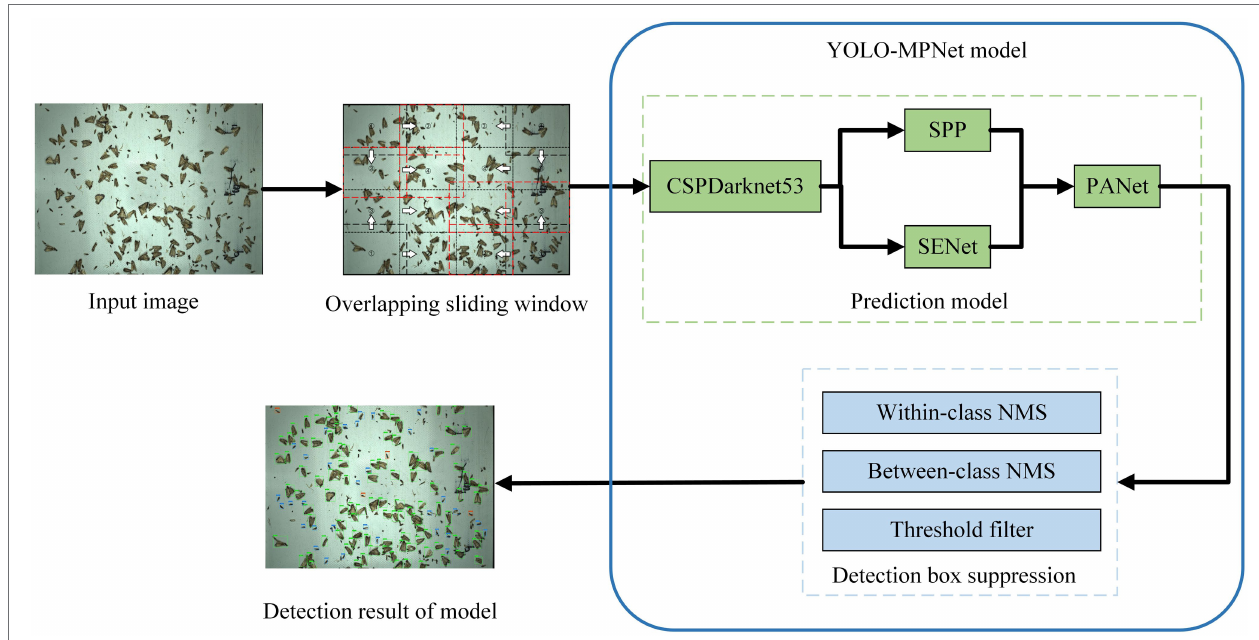
FIGURE 4 | The network framework of YOLO-MPNet